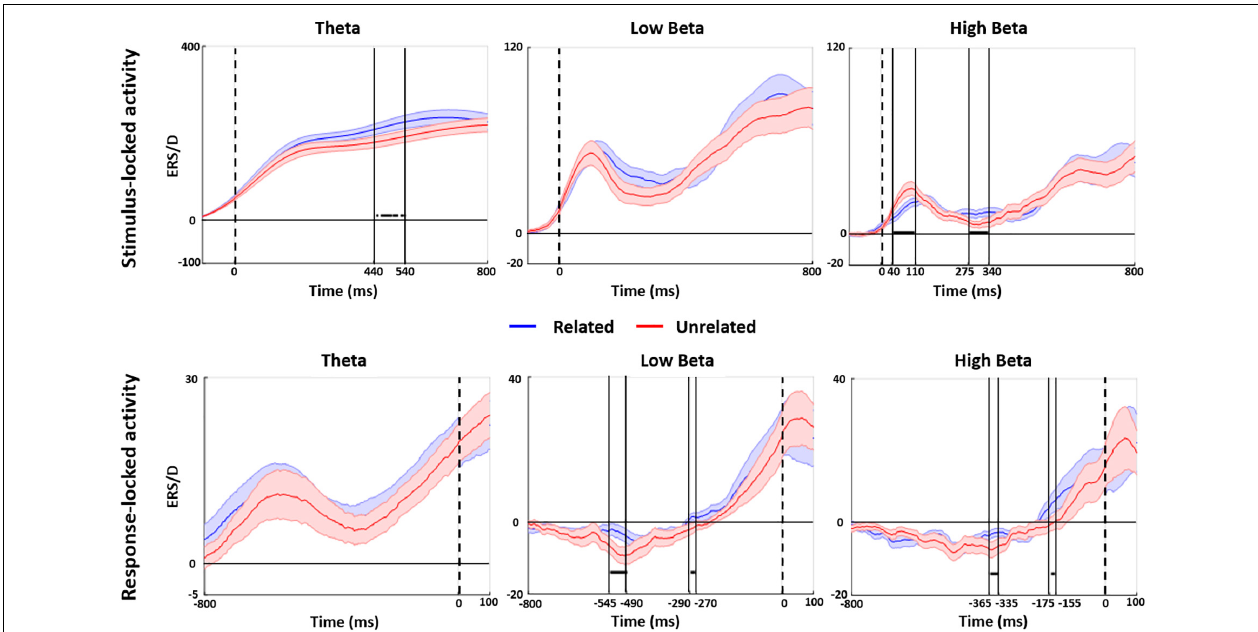
FIGURE 4 | Stimulus and response-locked time-frequency analyses. Point-by-point stimulus-locked (upper panel) and response-locked (lower panel) analyses of related (blue solid line) and unrelated (red solid line) distractors are shown for the FCz electrode with the shaded area of the same color highlighting standard error. Horizontal black thick lines indicate a significant group difference between related vs. unrelated distractor conditions (permutation t -test at p =